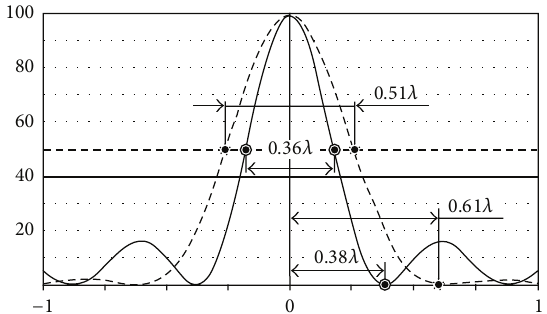
Figure 1: Illustration of the focal spot for the full-aperture illumina- tion and with narrow ring (𝑅 = 𝑓)